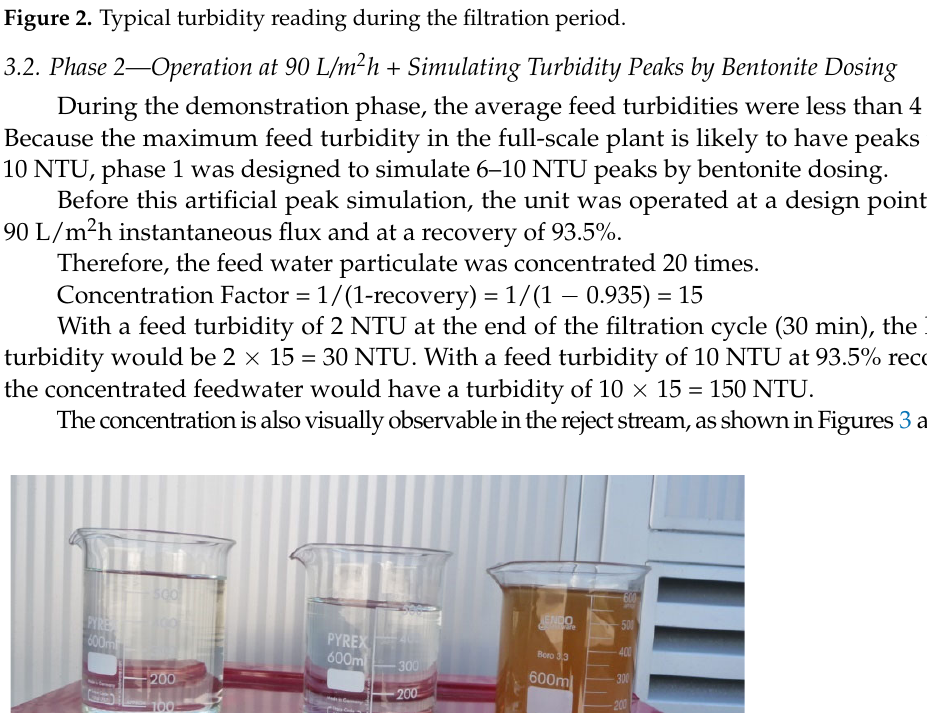
Figure 4. Reject water after 30 min sedimentation. Summary of operation at 90 L/m 2 h: o Instantaneous flux rate of 90 L/m 2 h. o Average feed temperature of 14  C. o